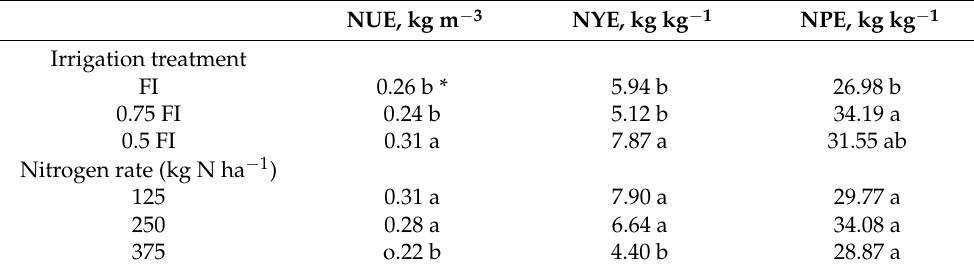
Table 3. Nitrogen use efficiency (NUE) and nitrogen yield efficiency (NYE) and physiological N efficiency (NPE) at different irrigation regimes and N application rates in the second